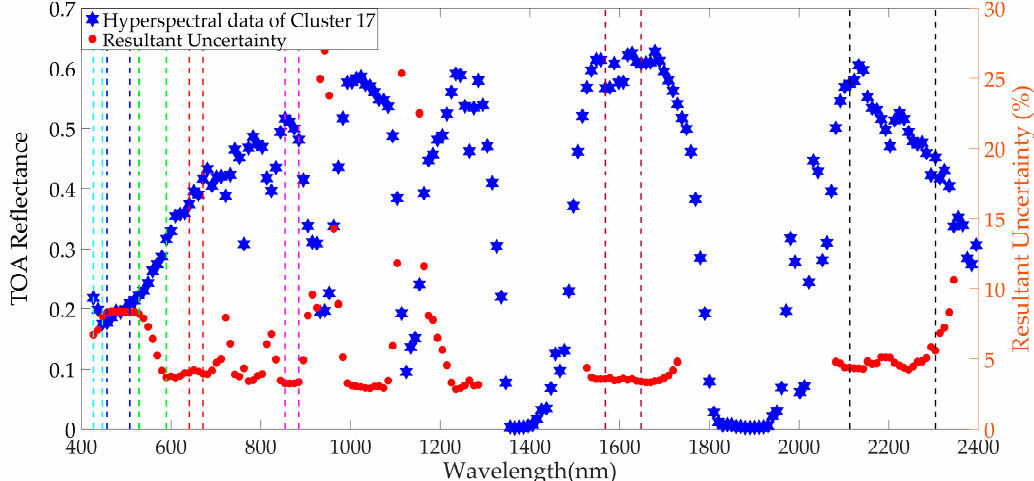
Figure A14. Estimated representative hyperspectral profile of Cluster 17 and its resultant uncertainty.